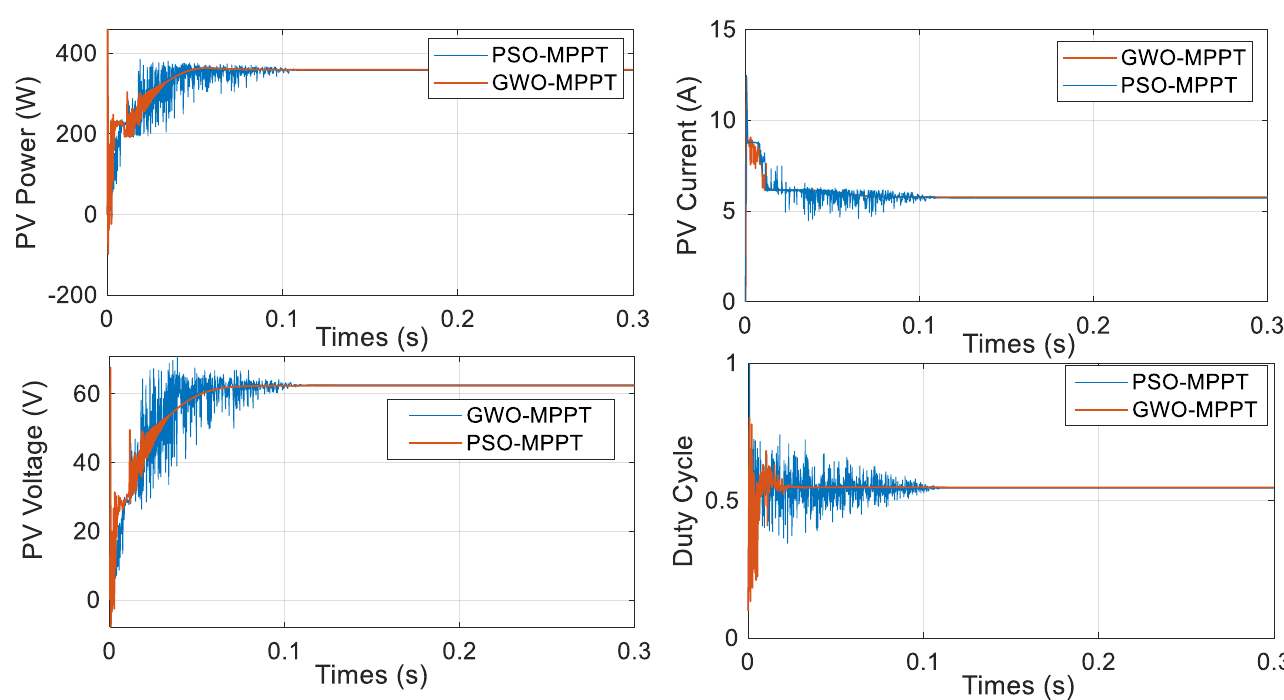
Table 5. Comparative study between PSO-MPPT and